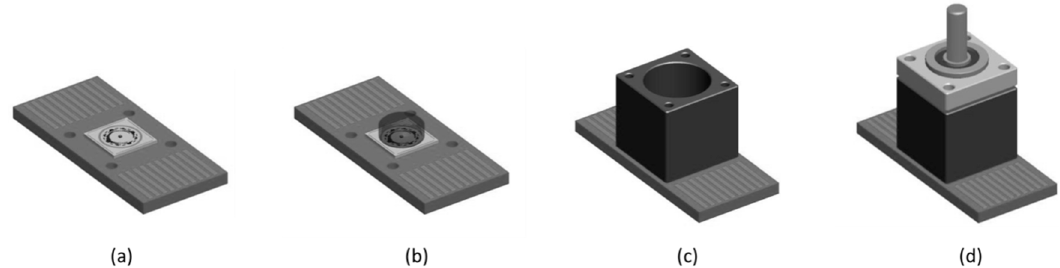
Figure 13. Assembly concept of the demonstrator. ( a ) Assembly of the opto-ASIC onto the printed circuit board (PCB) and the laser diode onto the opto-ASIC; ( b ) assembly of the lens onto the opto-ASIC; ( c ) assembly of the housing; ( d ) assembly of the encoder disc, the bearing, and the